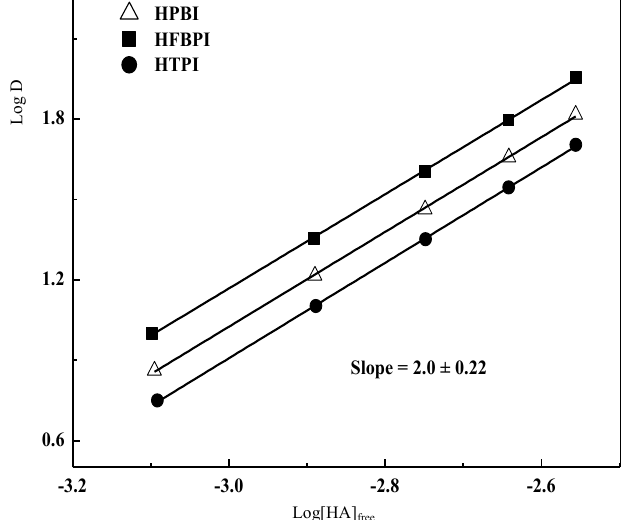
Figure 3. Effect of 4-aroyl-3-phenyl-5-isoxazolones (HA) on Pd(II) extraction. Aqueous phase = 1.12 × 10 -4 mol L -1 Pd(II) at 0.1 mol L -1 H + and 1.0 mol L -1 Cl - , Organic phase = 1.0 × 10 -3 mol L -1 in CHCl , Equilibration time = 45 3